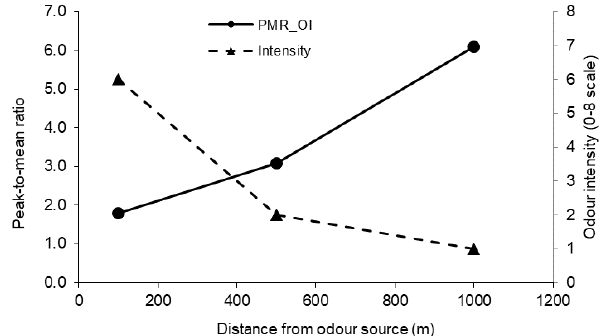
Figure 8. Variations of the PMR_OI (30 minute averaging time) and odour intensity with distance from the odour source.